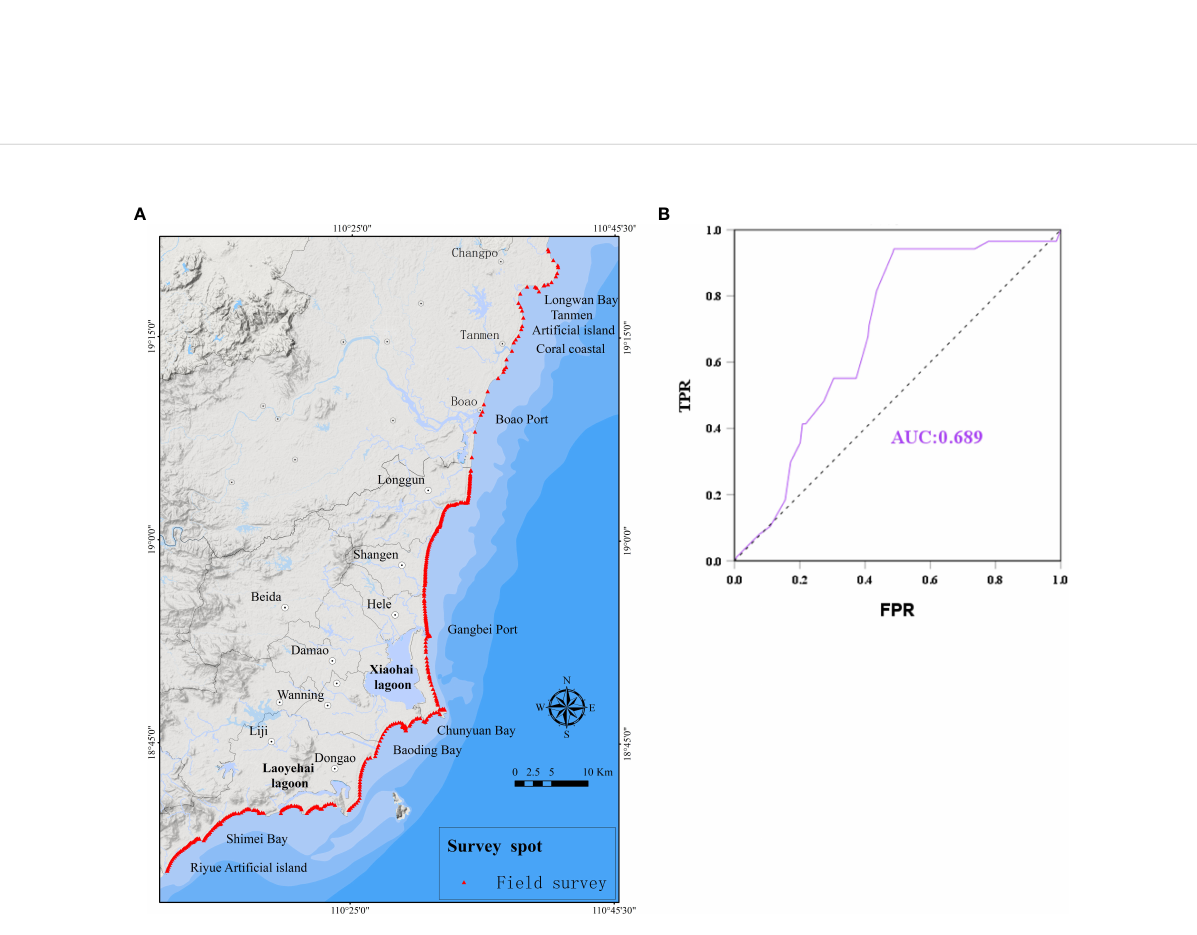
FIGURE 11 (A) Spatial distribution of fi eld survey sites in 2021; (B) ROC curve and AUC =